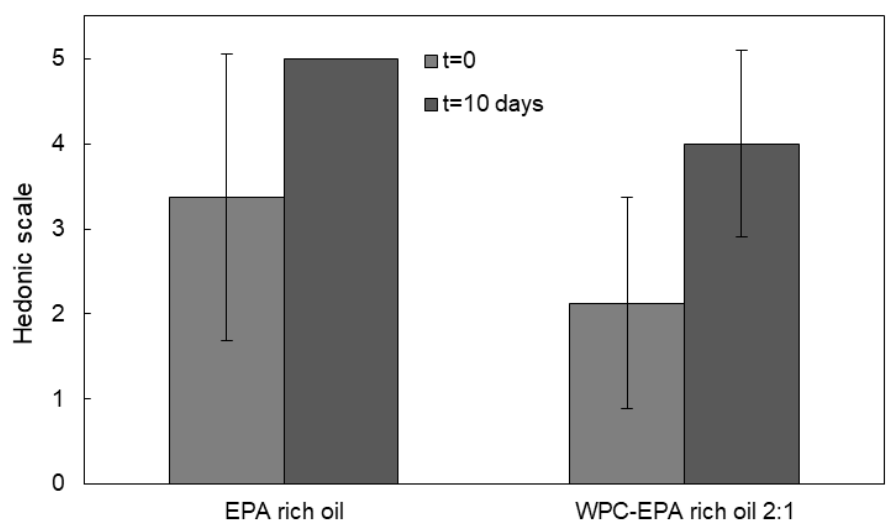
Figure 8. Comparison of the organoleptic impact of reconstituted powder milk containing free oil and EPA-rich oil-loaded microcapsules for fresh samples (t = 0) and upon the completion of the accelerated oxidation test. Data were expressed as mean value ± standard deviation.